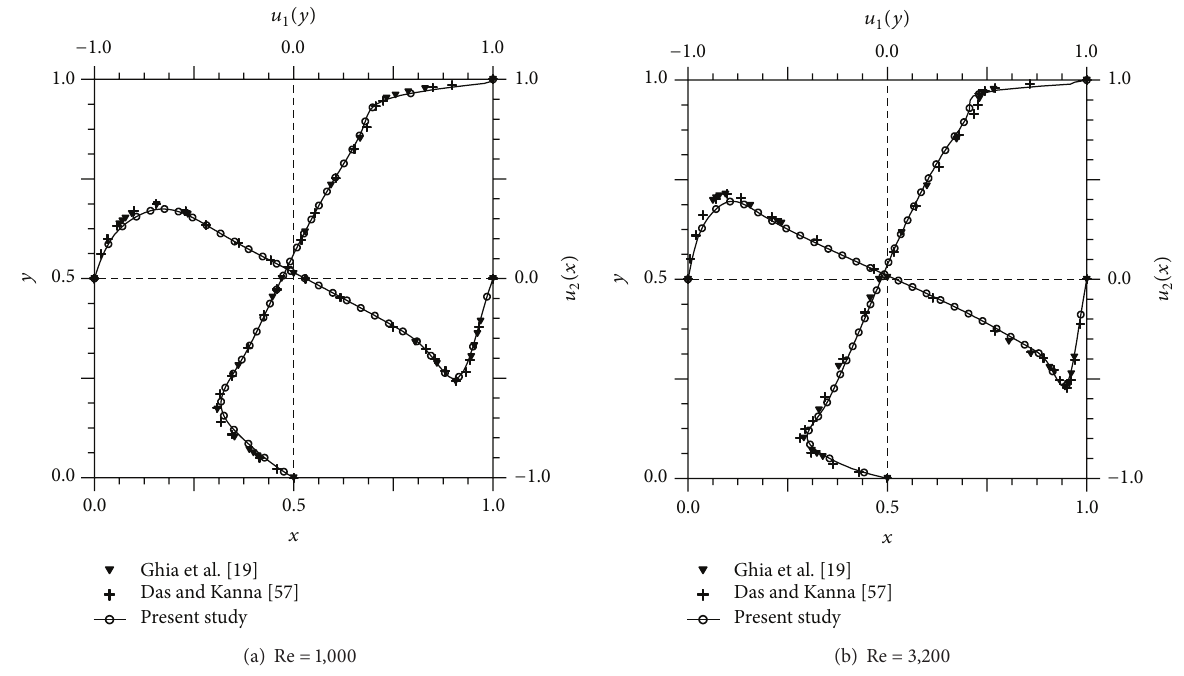
Figure 10: Velocity profiles of side cavity problem along the horizontal and vertical center lines (unit of velocity: m/s).